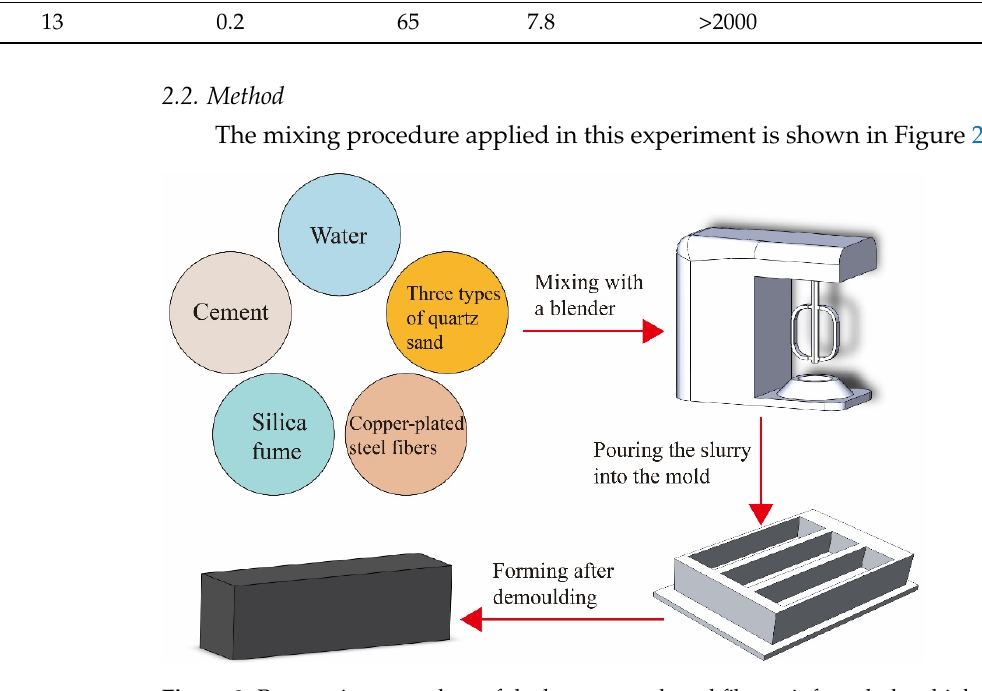
Figure 2. Preparation procedure of the brass-coated steel fiber-reinforced ultra-high strength con- cert.